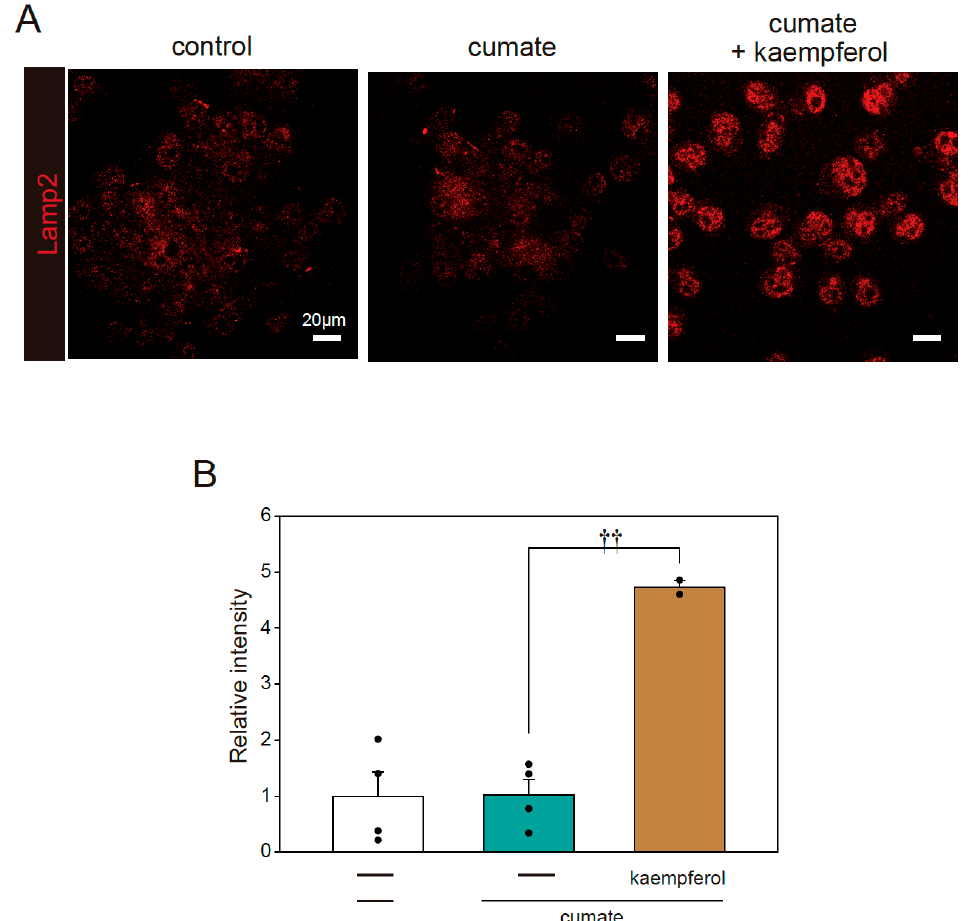
Figure 6. Kaempferol enhances lysosomal function. α -Syn WT -N2a cells were treated with 5 µ M kaempferol in the presence or absence of 50 µ g/mL of cumate for 48 h. Immunofluorescence staining with Lamp2 antibody was then performed. (A) Imaging of Lamp2. Scale bar: 20 µ m. (B) Quantified analysis of imaging. Data are expressed as means ± SEM from four independent experiments. †† p < 0.01 vs. α -Syn WT -N2a cells in the presence of 50 µ g/mL